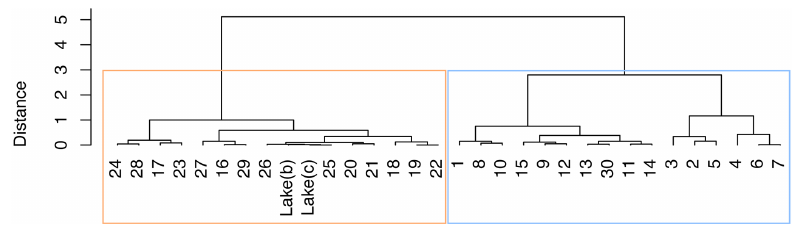
Figure 3. Euclidean hierarchical clustering of the δ 18 O‰ showing two clusters. The first cluster, marked with orange, groups with lake samples and is therefore regarded as a recharge site. The other cluster, marked with light blue, is possible groundwater discharge sites to the lake. The y axis denotes the linear distance between the δ 18 O‰ samples fed to the model. The third lake sample was lost during